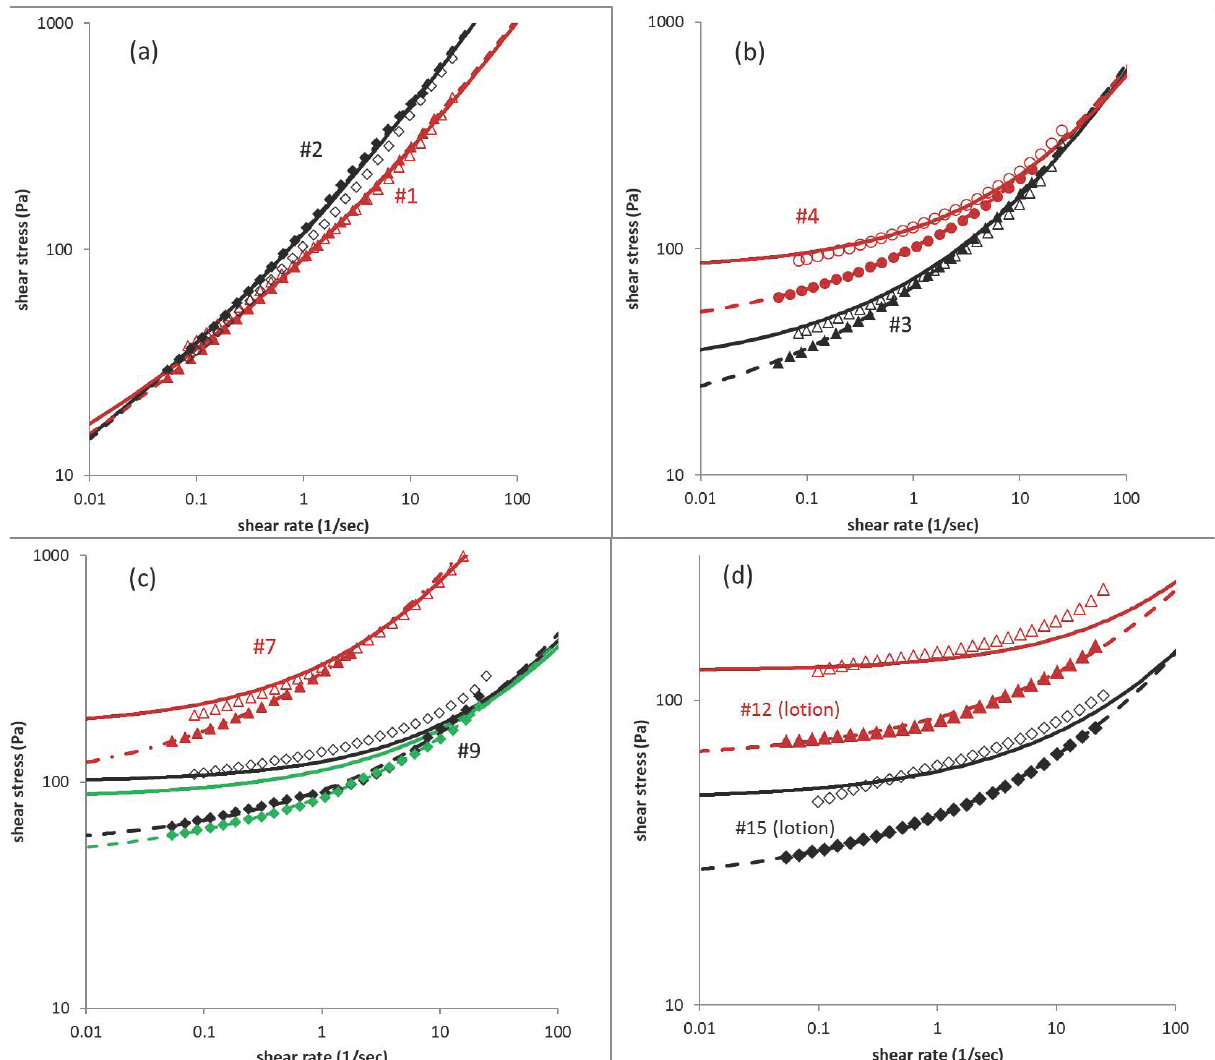
Figure 2: Experimental and calculated flow curves for selected samples from Table 1. Data for pastes (a,b,c) were obtained with HA/V74 setup, for lotions (d) – with HB/V73. As an example of how the measurements compare, for one sample, #9, both HB/V73 (in green) and HA/V74 are shown. HA or HB symbols here indicate the type of the viscometer spring, while V74 or V73 – the type of the vane as defined in Table 2. Empty symbols on the plots are ARG2 rheometer data, filled symbols – Brookfield viscometers data. Dashed curves fit the latter to predict the former- solid curves are the